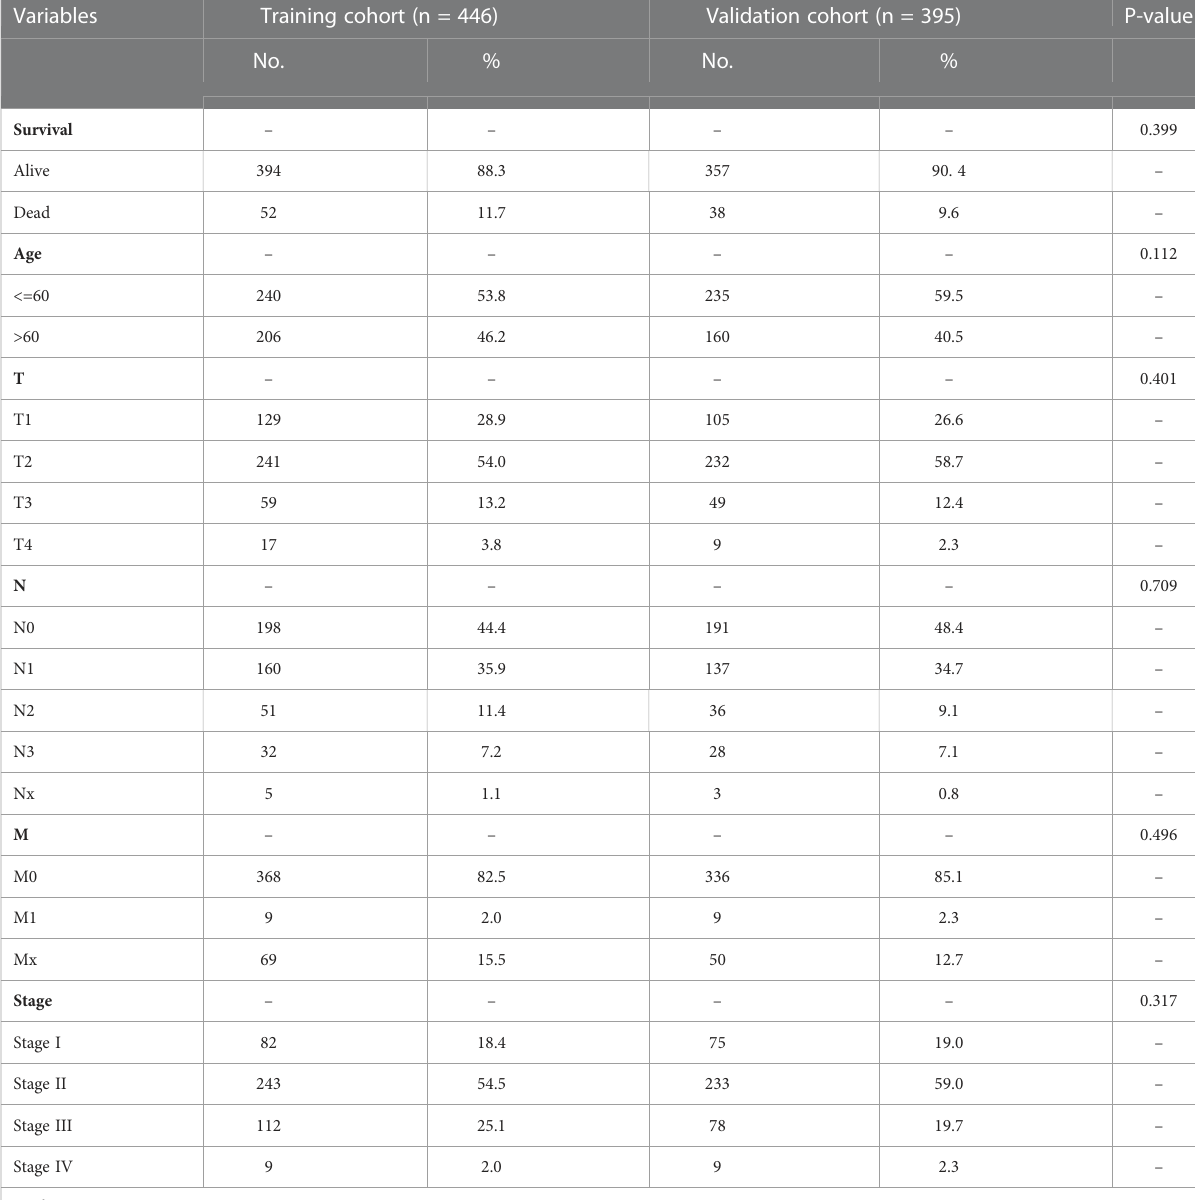
TABLE 1 Clinicopathological features of patients with BC in training and validation